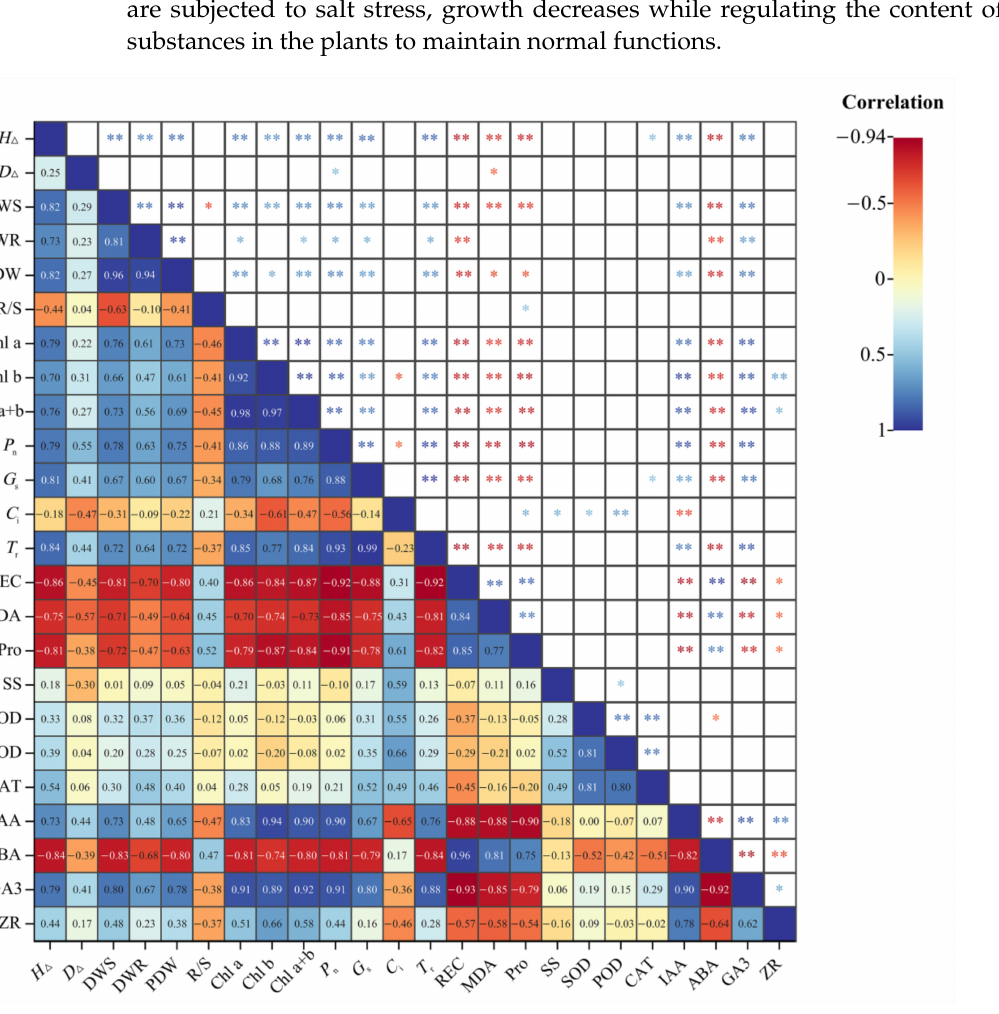
Figure 7. The correlation heatmap of every single index. * means significantly correlation, p < 0.05; ** means extremely significantly correlation, p < 0.01. Abbreviations of the corresponding indicators are shown in Figures